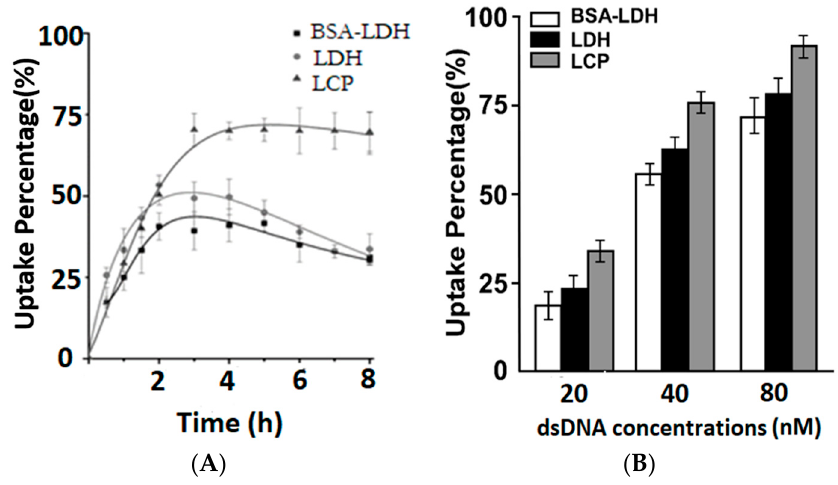
Figure 2. Cellular uptake profile of LDH and LCP NPs. ( A ) The fluorescence-activated cell sorting (FACS) results show the positive cell percentage vs. the time course (culture time) for EL4 cells treated with LDH-dsDNA, BSA-LDH-dsDNA and LCP-dsDNA hybrids at 40 nM of Cy-dsDNA. ( B ) The FACS results show the positive cell percentage vs. the treatment dose for EL4 cells treated with LDH-dsDNA, BSA-LDH-dsDNA and LCP-dsDNA hybrids for 4 h. All of the tests were done in triplicate.